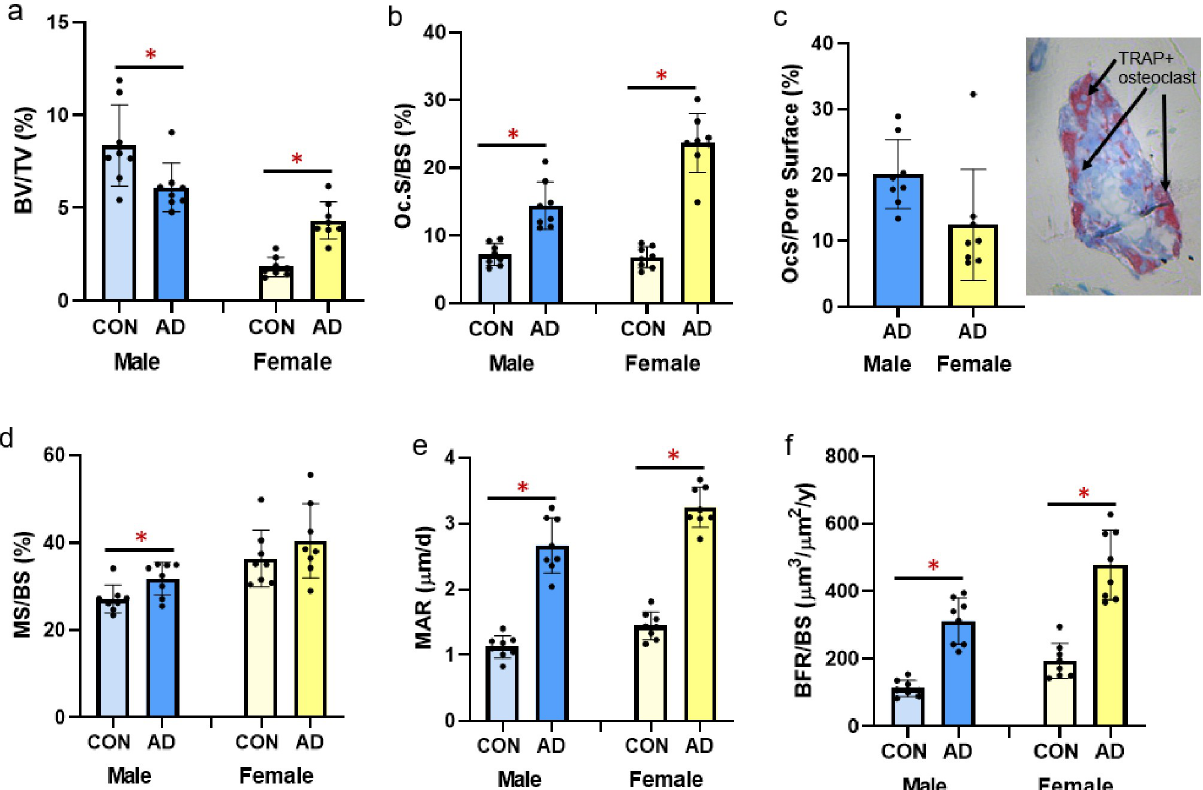
Fig 5. Trabecular bone volume and histomorphometry from the distal femur in male and female B6 mice. A) Trabecular bone volume (%BV/TV) from microCT analysis was statistically lower in male adenine mice compared to male controls, but statistically higher in female adenine mice compared to sex-matched controls. B) Osteoclast-covered trabecular surfaces (Oc.S/BS) were higher in both sexes of adenine mice compared to sex- matched controls. C) Osteoclast-covered pore surfaces in male and female adenine mice and a representative image of a cortical pore in the midshaft femur. D) Mineralized surface (MS/BS) was higher in male adenine mice vs. controls, but not different in female mice. E) Mineral apposition rate (MAR) was higher in both male and female adenine mice compared to sex-matched controls. F) Bone formation rate (BFR/BS) was higher in both sexes of adenine mice. Error bars = standard deviation. � Indicates statistical difference (p < 0.05) from t-test between control and adenine within each sex.